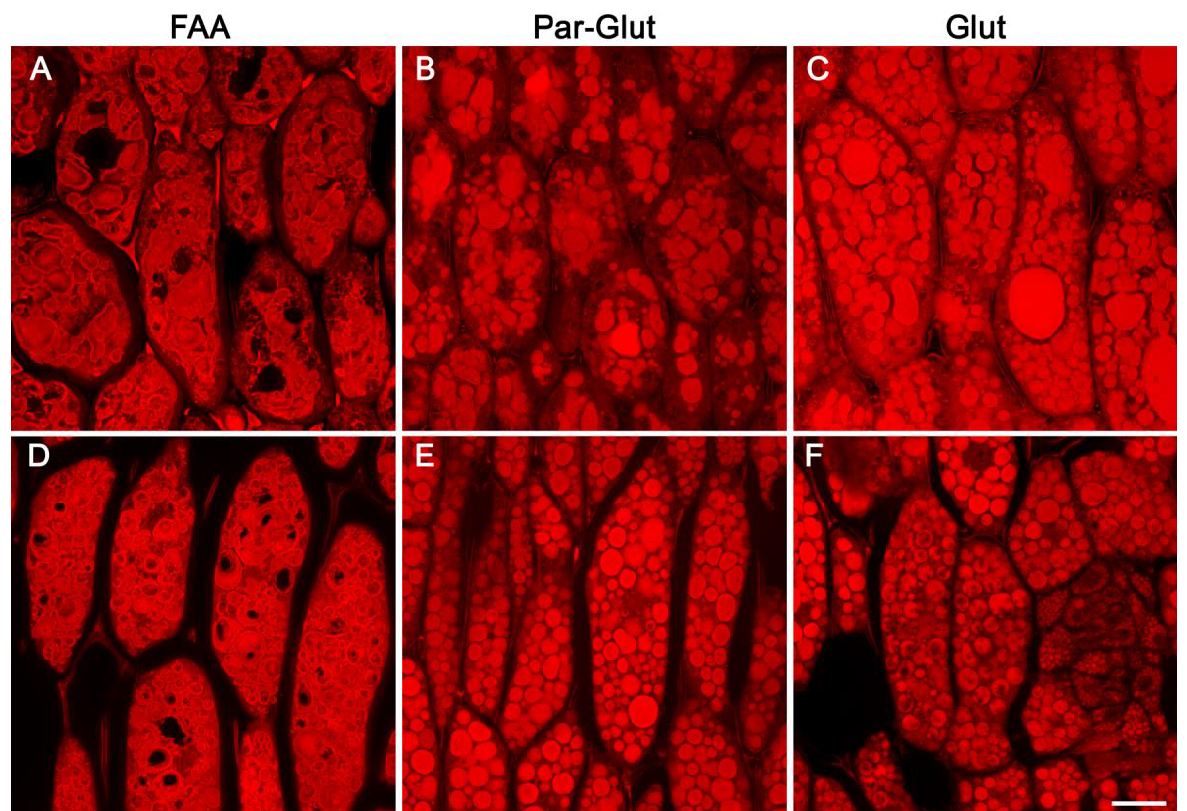
Figure 6. Confocal images of paraffin-embedded sections of the mature soybean cotyledon stained with eosin. ( A , D ) – fixed in FAA, ( B , E ) – fixed in 2% paraformaldehyde and 2% glutaraldehyde, ( C , F ) – fixed in 2.5% glutaraldehyde. Pictures on the top panel represent mature seeds, and those in the lower panel denote developing seeds at R6 stage. Scale bar in panel F is 20 µm and represents the scale for all panels.